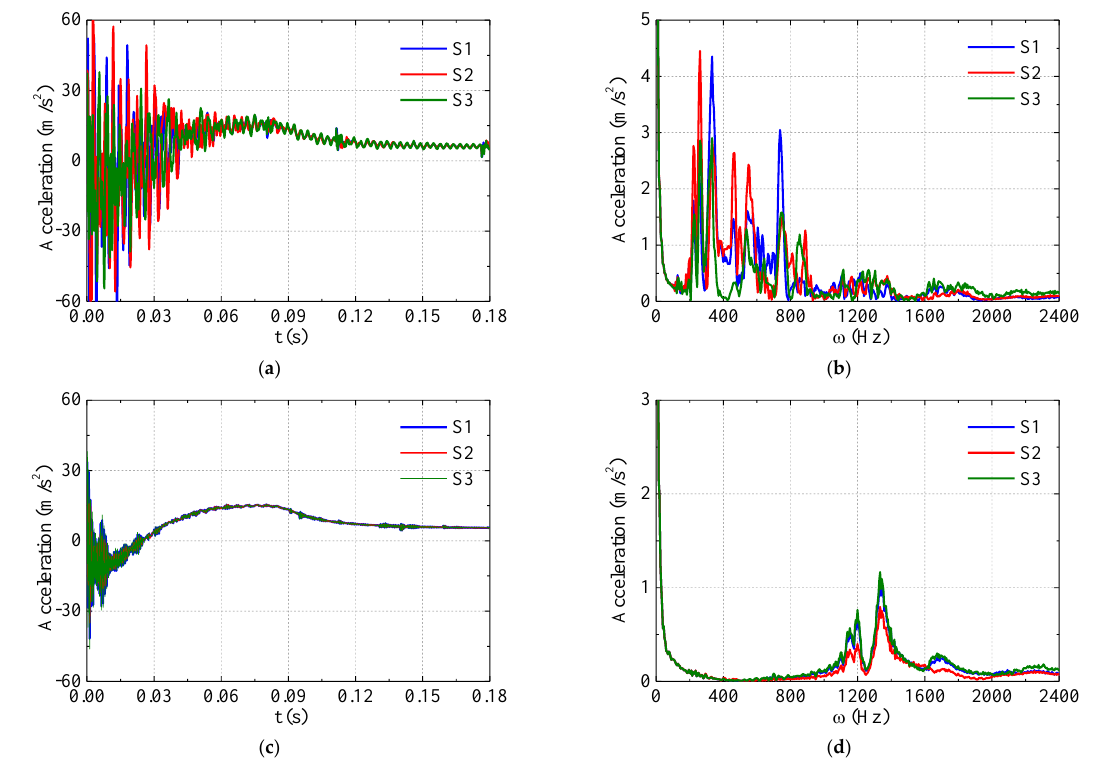
Moreover, the vertical acceleration at bottom points S1–3 during the water entry pro- cess is shown in Figure 22a,b. It is seen that in the time series, the high-frequency vibrations are very pronounced initially, which is probably caused by numerical dispersion. Then, the acceleration tends to be steady, and small amplitude whipping loads are superposed on the low-frequency signal. As seen from the spectra, there exist several peaks, which represent different natural frequencies of various types of vibration modes. In order to understand the vertical vibration modal behavior, the numerical simulation is further conducted by releasing only one degree of freedom (i.e., vertical displacement) of all the FE nodes. The corresponding acceleration results of both time series and frequency spectra are shown in Figure 22c,d. It is seen that the first three orders of natural frequency of vertical vibration, 1202 Hz, 1334 Hz and 1670 Hz, can be clearly identified from the frequency spectra curves.